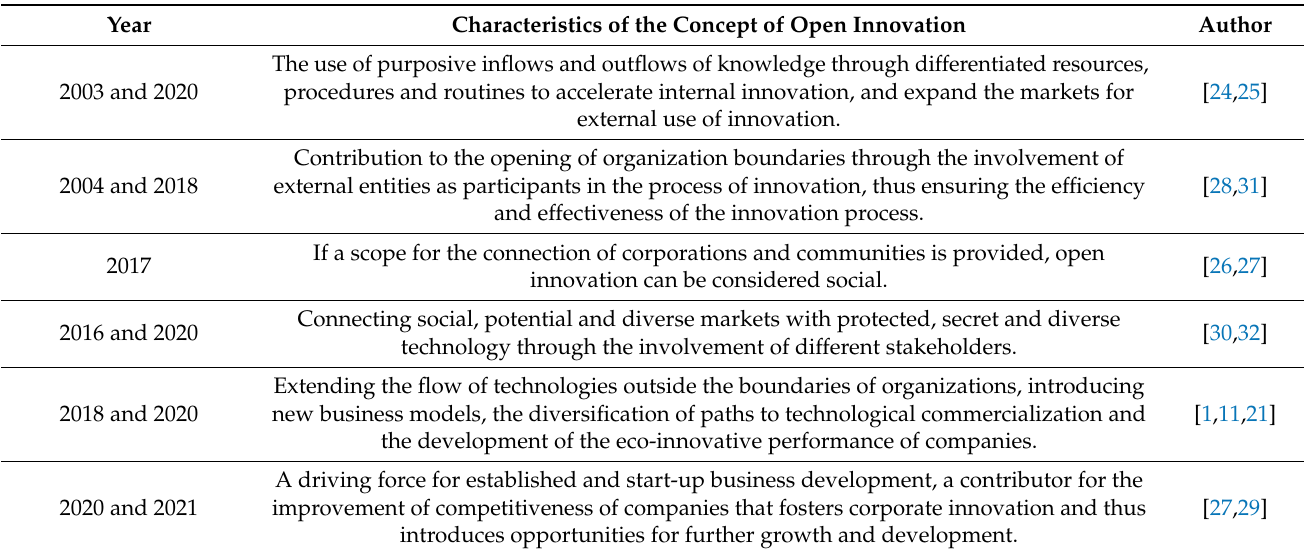
Table 2. The characteristics of the concept of open